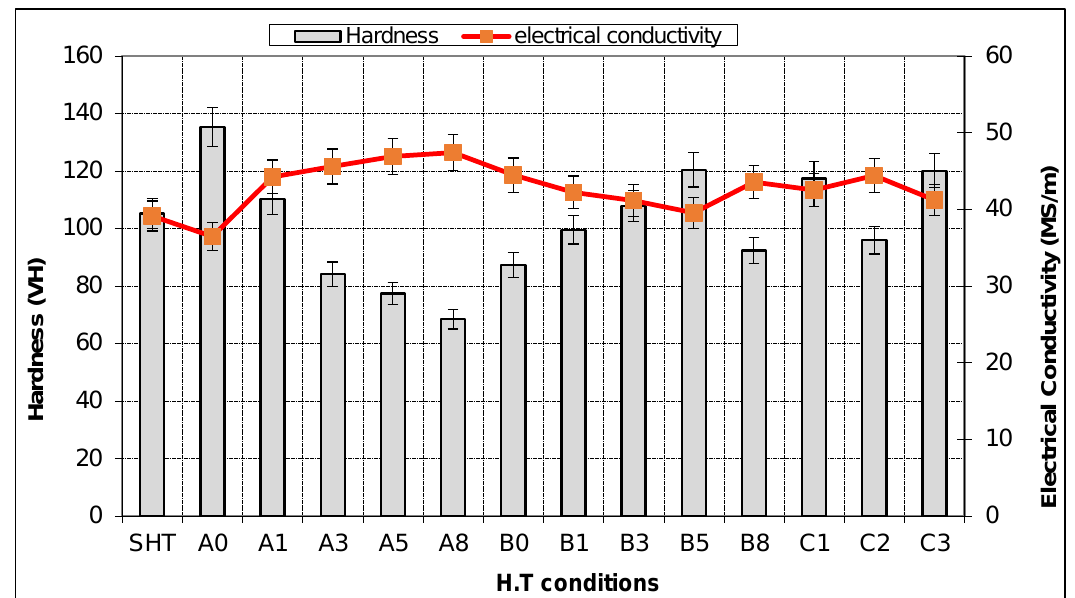
Figure 1. Hardness and electrical conductivity of water quenching A357-SSM heat treated using multiple thermal aging treatments.